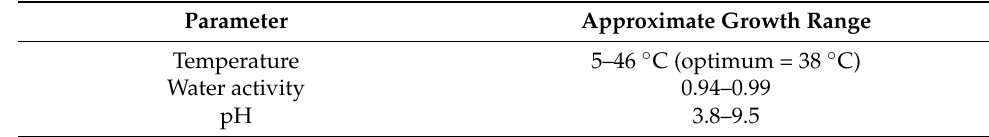
Table 3. Parameters for survival and growth of Salmonella (adapted from